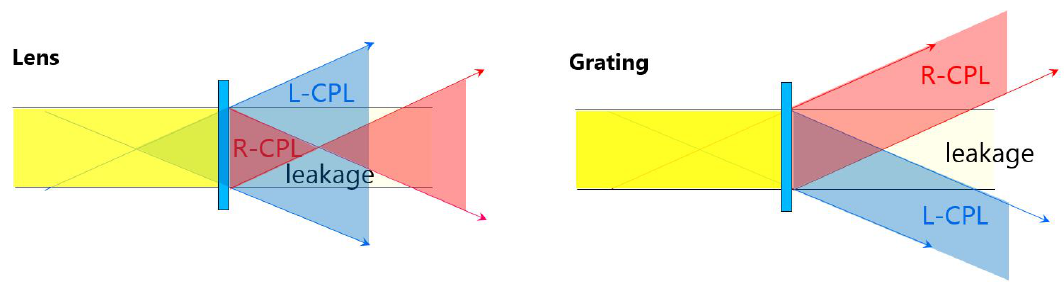
Figure 2. Schematic representation of the effect of the lens and the grating on a incoming wavefront. R-CPL and L-CPL stand for right- and left- circularly polarizer light,